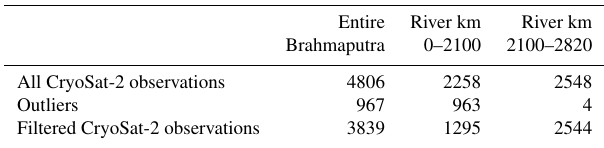
Table 2. Number of CryoSat-2 observations and outliers over the river mask of the Brahmaputra River from 2010 to 2013. River kilo- metre 2100 and downstream is also referred to as Assam